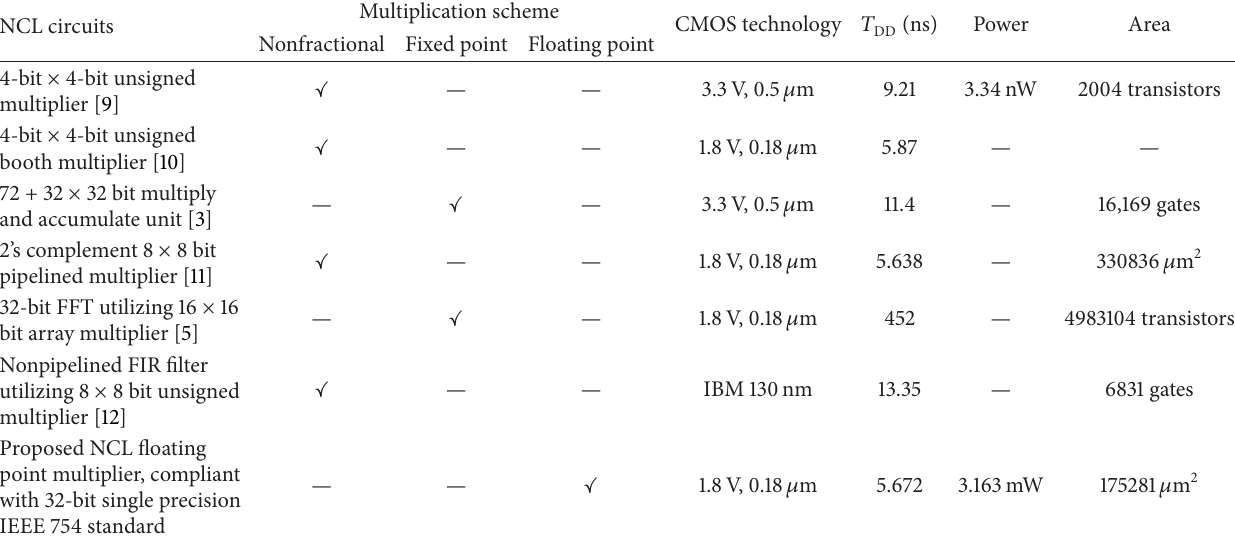
Table 6: Comparison of existing and proposed NCL